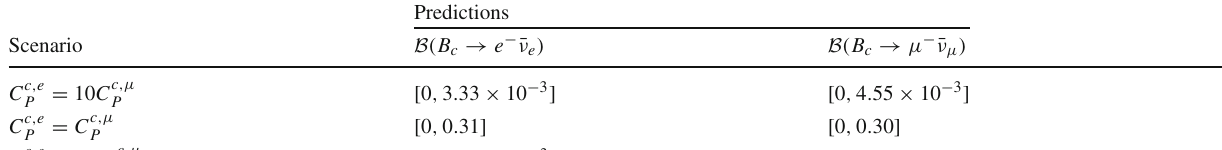
Table 10 Values of | V cb | obtained in different NP scenarios correlating C c , e